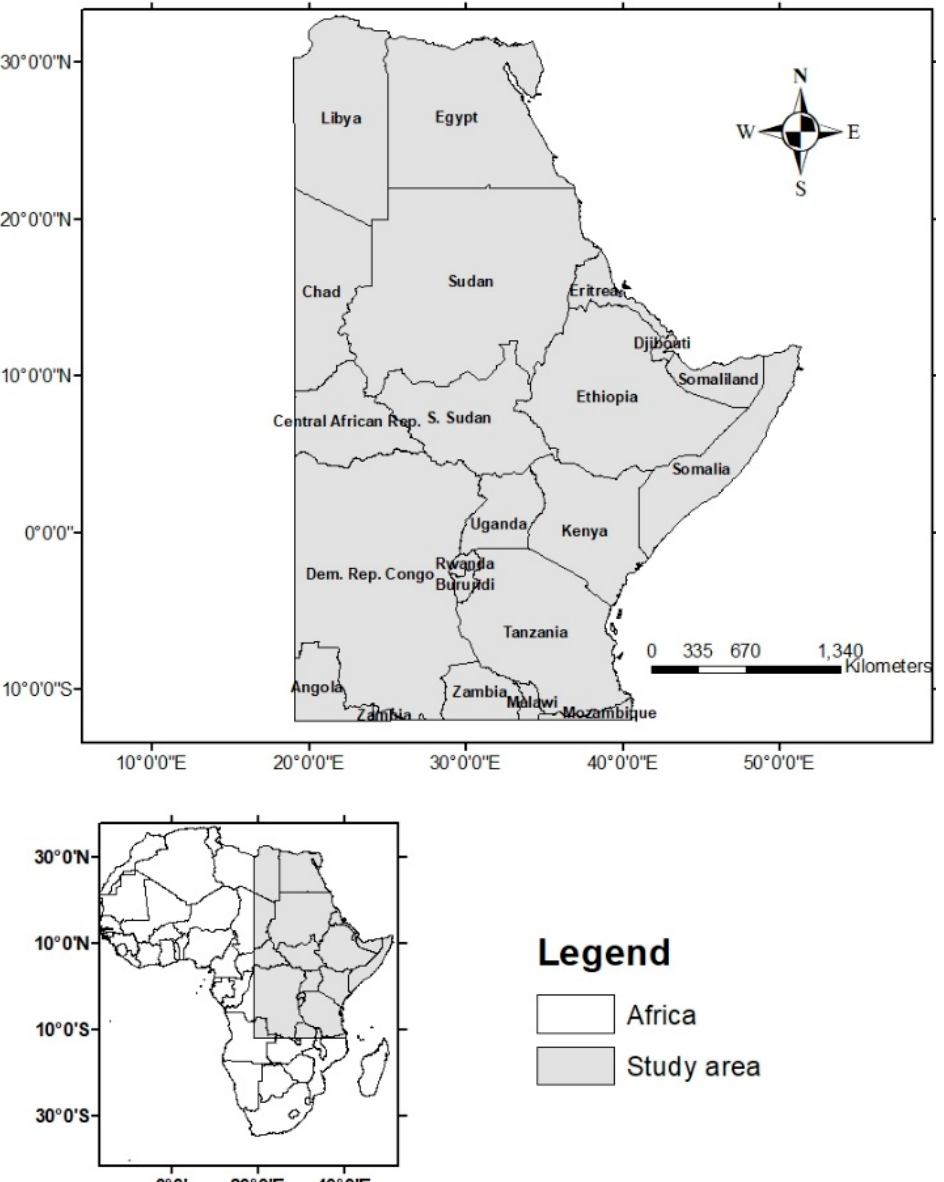
Figure 1. Map of the study area, gray shaded region, and its location in Africa.